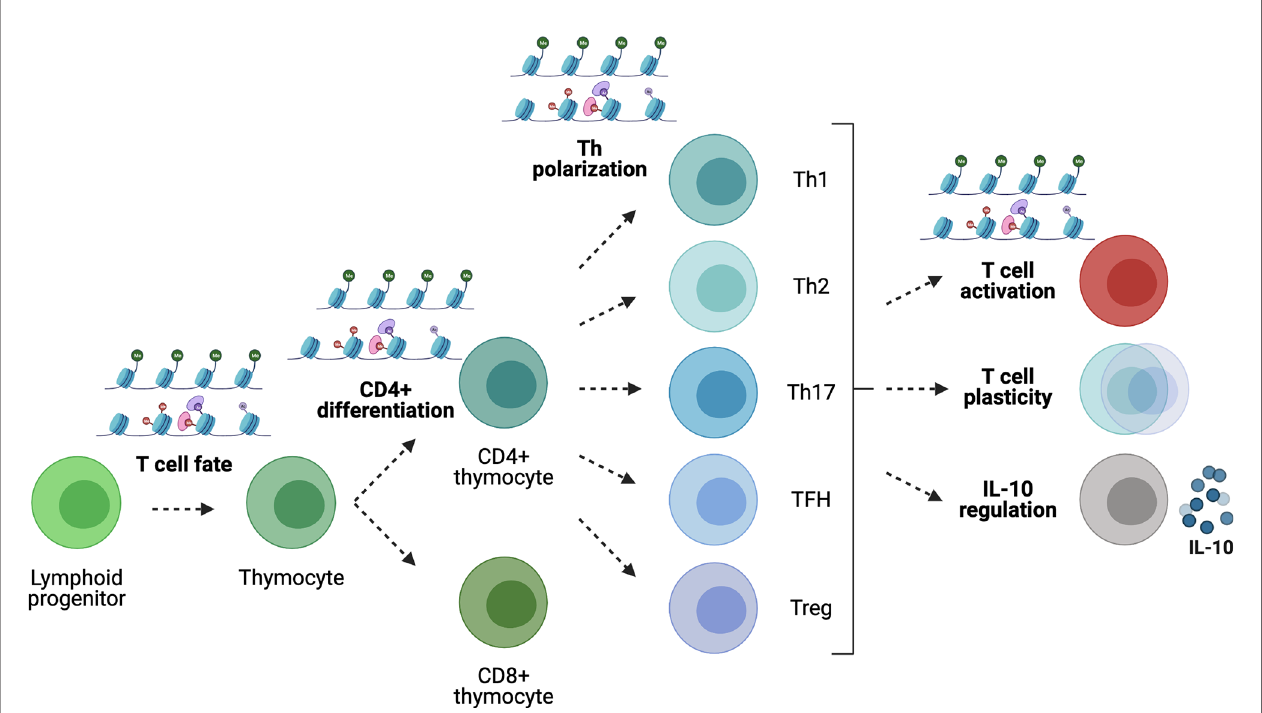
FIGURE 4 | Gene regulation in T cells. Epigenetic modi fi cations play key roles during T-cell development, differentiation and Th polarization. In the periphery, the epigenome regulates Th cell lineage stability/plasticity as well as IL-10 expression